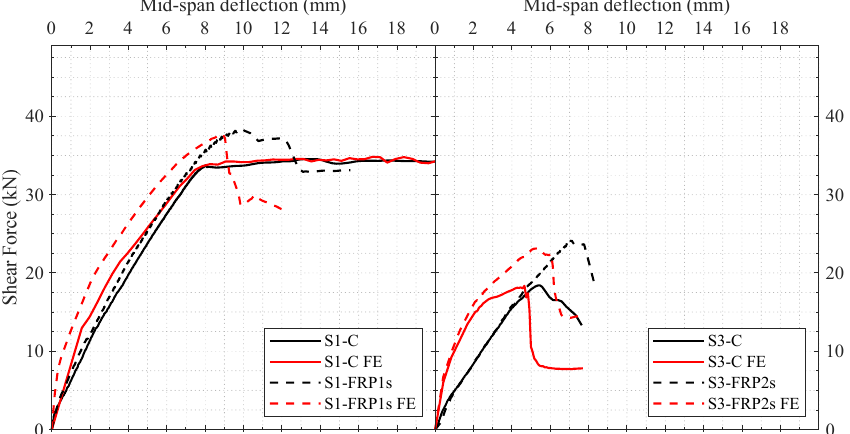
Figure 12. FE and experimental force vs mid-span deflection plots for the control beam.